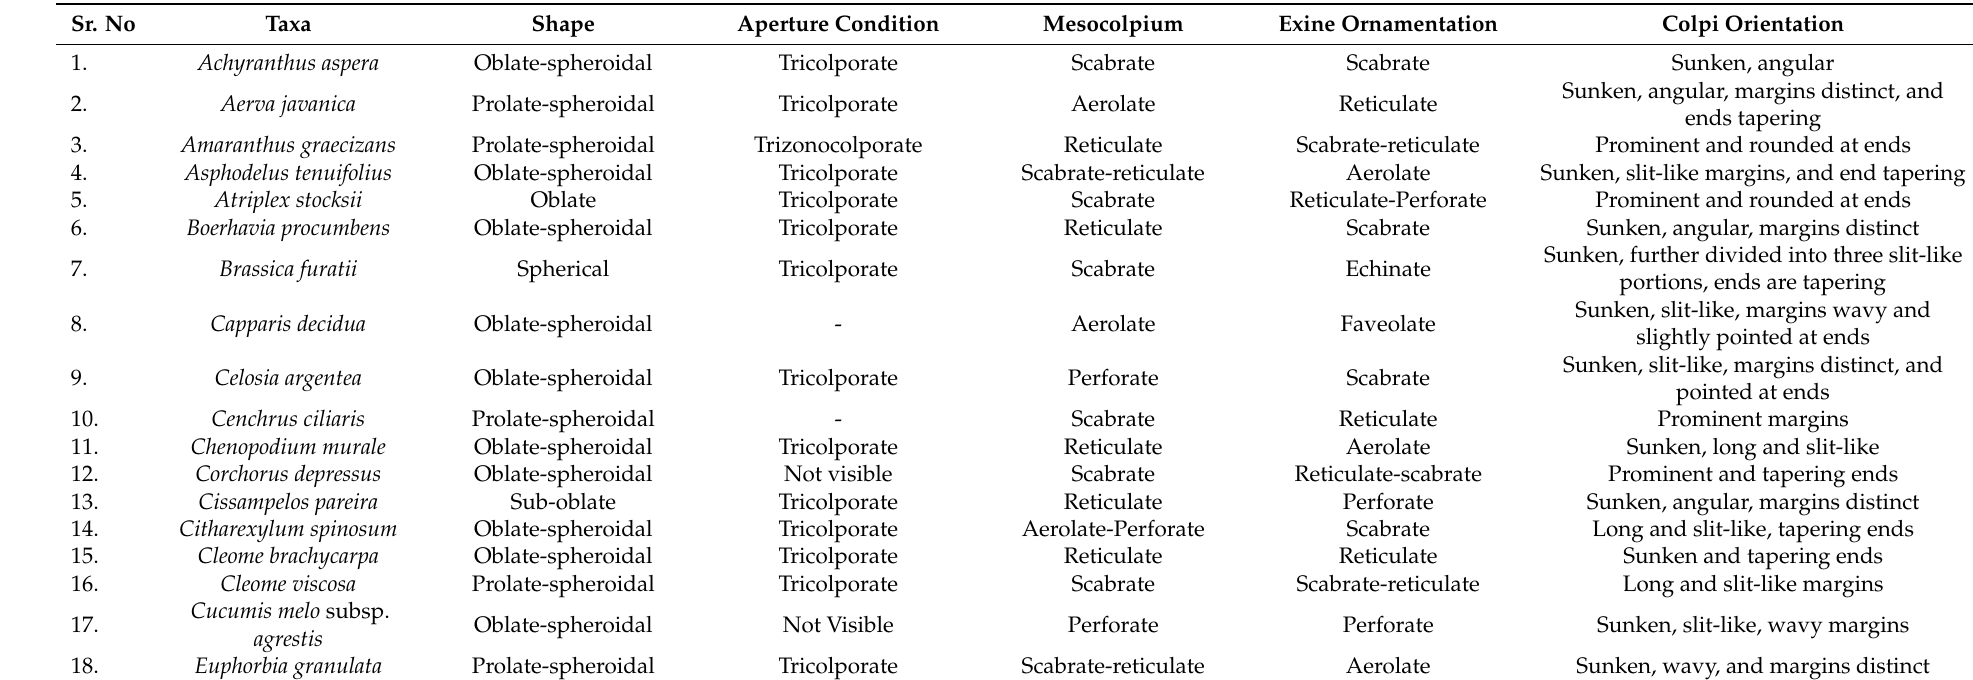
Table 2. Qualitative data of the pollen of weeds members from the Potohar region of